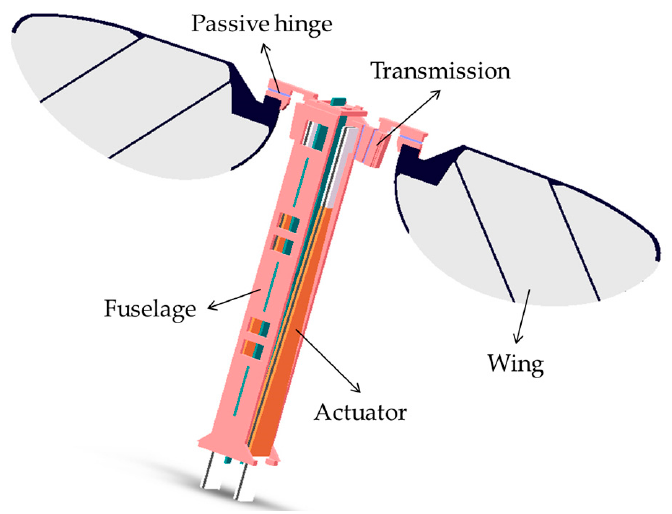
Figure 1. Three ‐ dimensional (3D) model of a flapping ‐ wing micro air vehicle. Figure 1. Three-dimensional (3D) model of a flapping-wing micro air vehicle. The driving mechanism of this flapping-wing micro air vehicle uses the piezoelectric ceramic bimorph bending actuator [21], which was designed by the team of Professor R J Wood of Harvard University [22,23]. The actuator was made of PZT − 5H piezoelectric ceramic sheets, carbon fiber, and glass fiber sheets, as shown in Figure 2a. The movement of insects’ wings in flight is mainly composed of two parts: torsional movement along the leading edge of the wings and reciprocating flapping movement with a high angle of attack. They are actuated by the flight muscles of the chest cavity with multiple rotational degrees of freedom, and the generation of the lift force is realized under the joint action of the two movements. We use the terms “upstroke” and “downstroke” to describe the flapping movement of the wings from belly to back and back to belly. A four-bar linkage mechanism is designed as the transmission mechanism of the flapping-wing micro air vehicle, inspired by the system of the chest cavity of the bee shown in Figure 2b. The hinge mechanism is capable of converting minor deflections into visible angle changes. Figure 2c depicts the plane mechanisms design. The transmission mechanism is composed of two symmetrical arrangements on both sides of the four-bar linkage. The middle of the symmetrical linkage is the actuate input. The two linkage mechanisms can amplify the input actuate displacement into the flapping motion of the wings. This transmission mechanism is a single-input dual-output type, so the flapping motion of the two wings is always symmetrical, and it can only generate upward lift. It cannot create forces